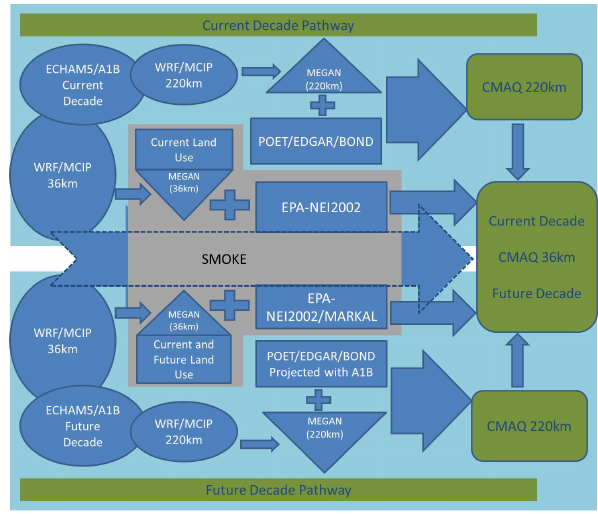
Figure 2. Schematic of the modeling framework.